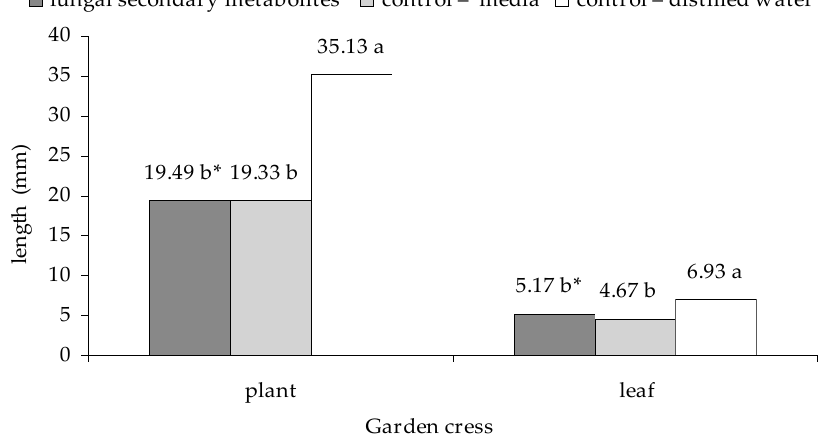
Figure 4. Effect of the culture filtrates from 18 strains of E. nigrum on the growth of garden cress seedlings after 7 days of incubation. Means followed by the same letter (*) are not statistically different at the α ≤ 0.01 level according to the Tukey HSD test.